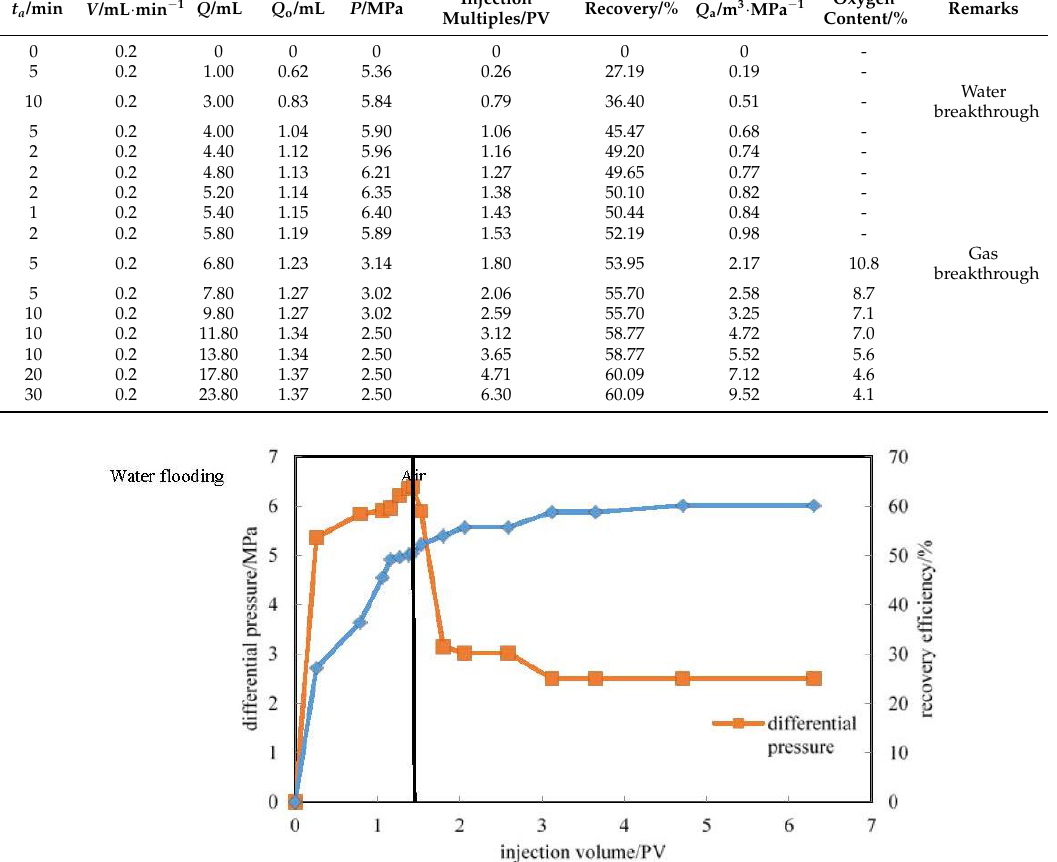
Figure 10. Pressure difference, recovery ratio relationship of multiple injections.